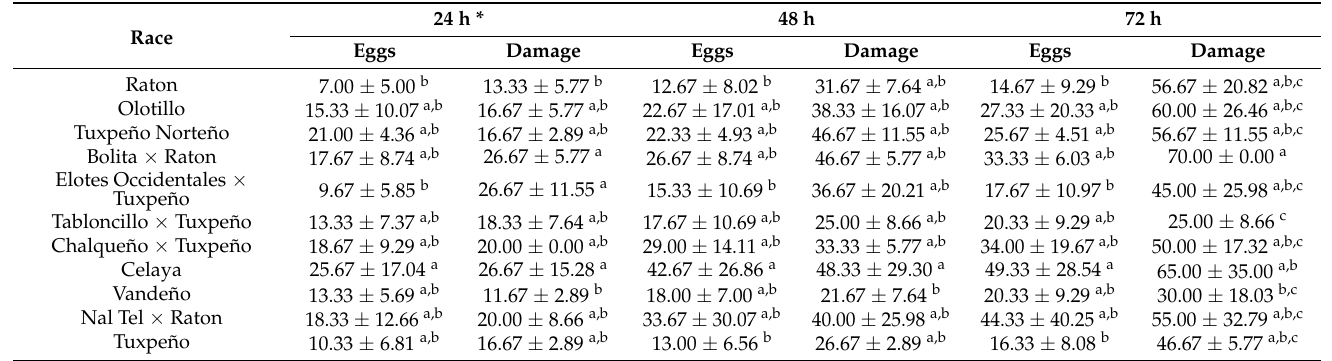
* Means values and ± standard deviation (SD) is presented. Different letters indicate significant differences ( p < 0.05; MANOVA and LSD’s test).